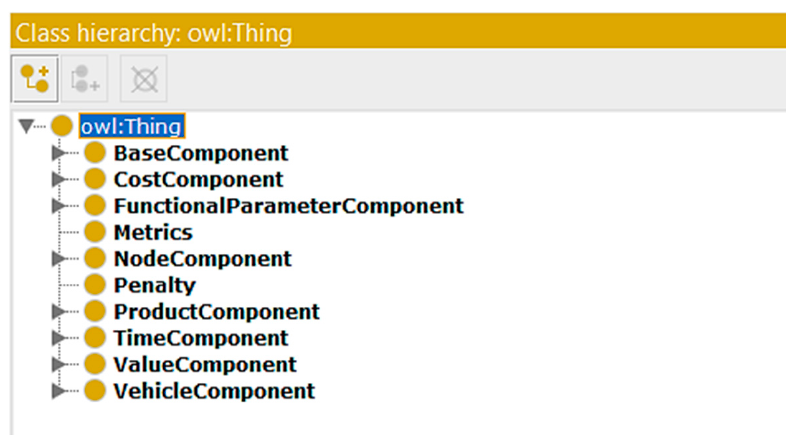
Figure A1. The ontology class hierarchy.